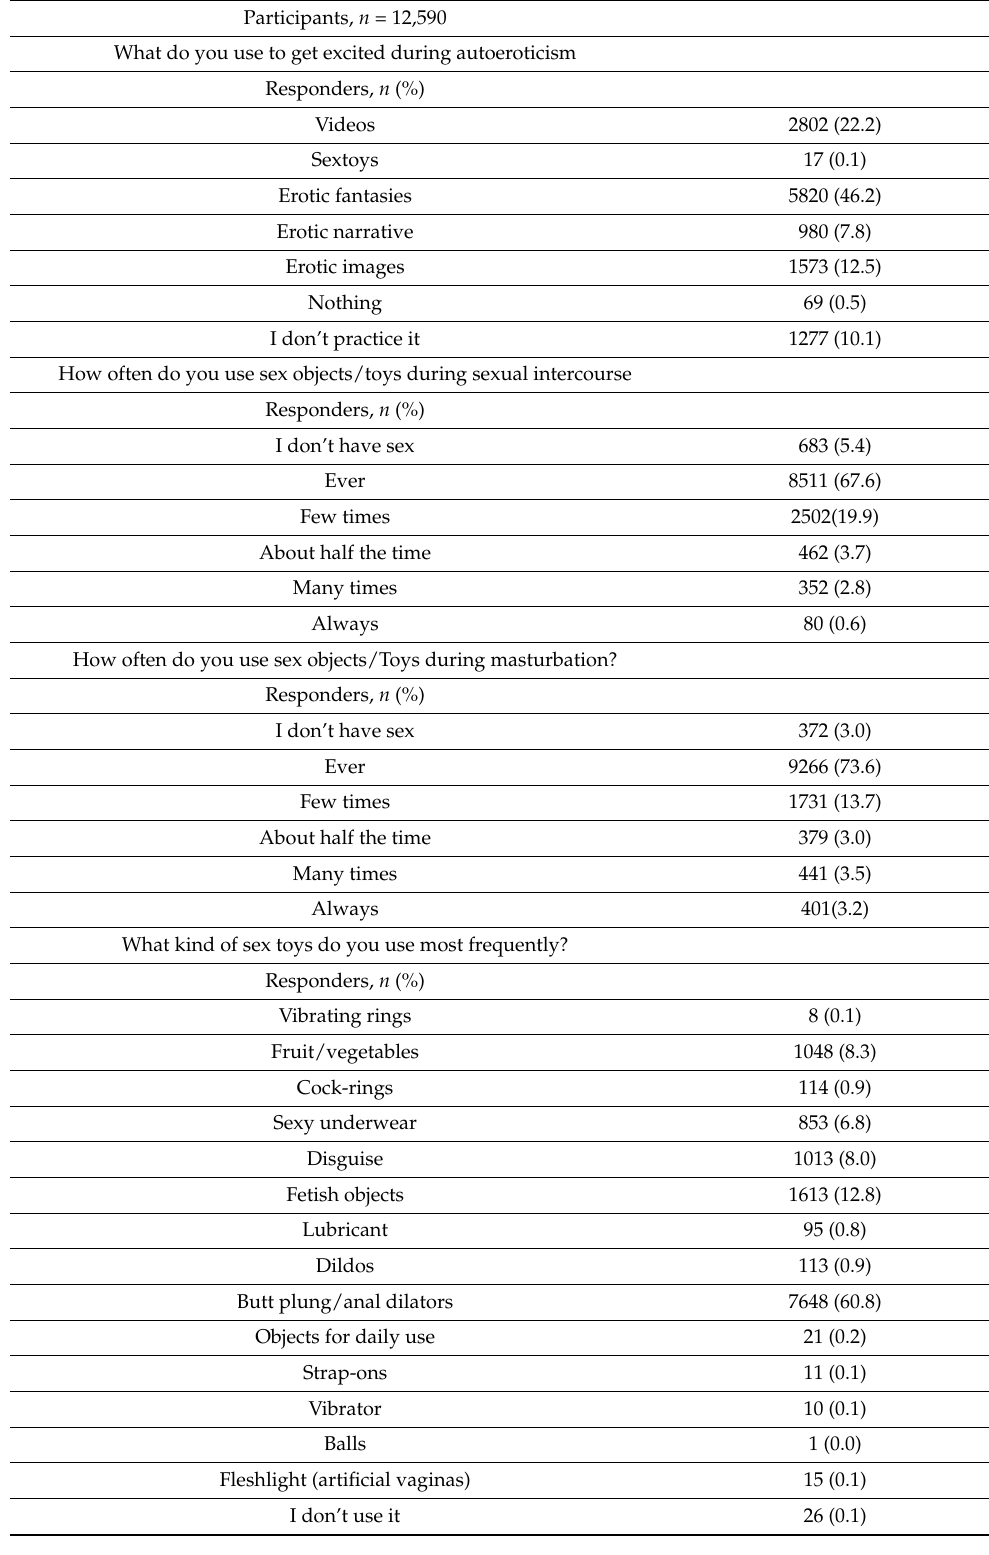
Table 3. Sex toys use in the total